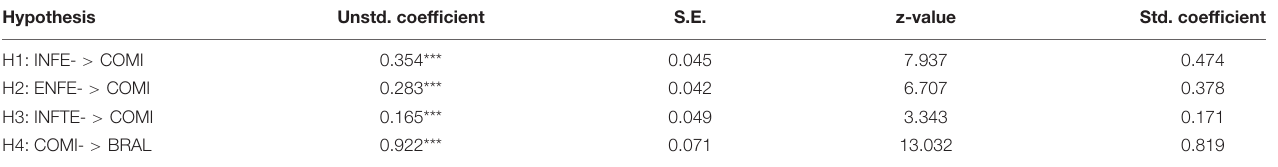
TABLE 5 | Regression